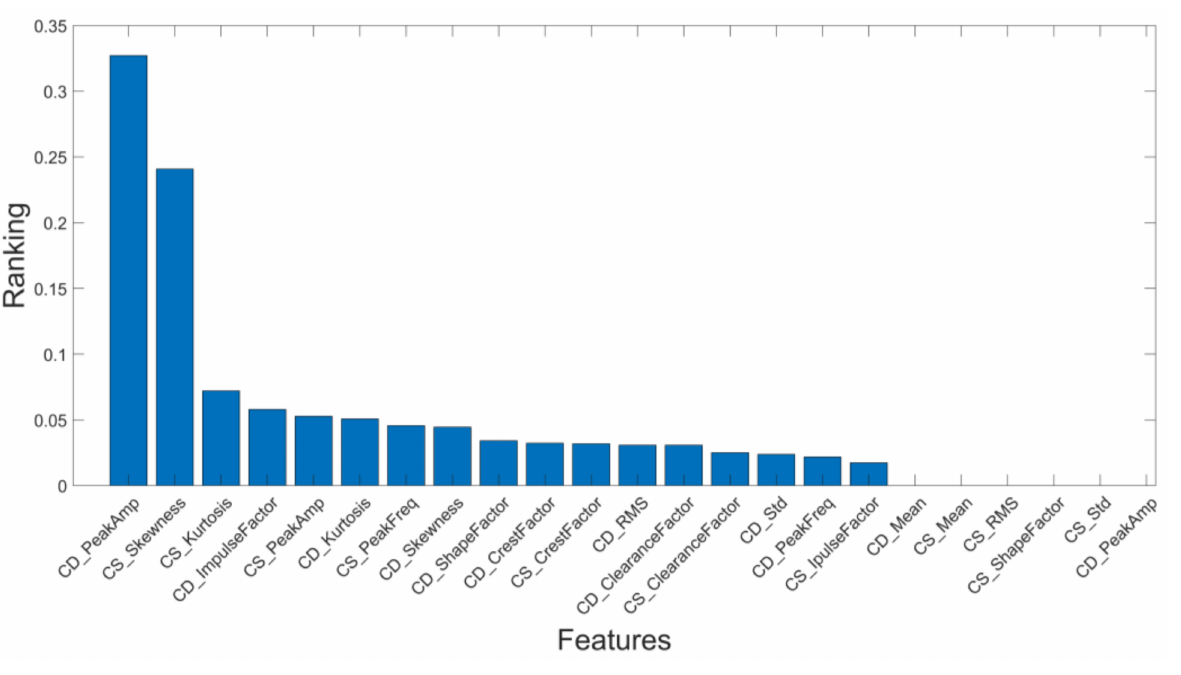
Figure 5. Significance ranking of the features that satisfied the condition of the greatest applicability with minimal redundancy. Obtained from the pressure waveforms (static and dynamic) in the discharge port of the pump.